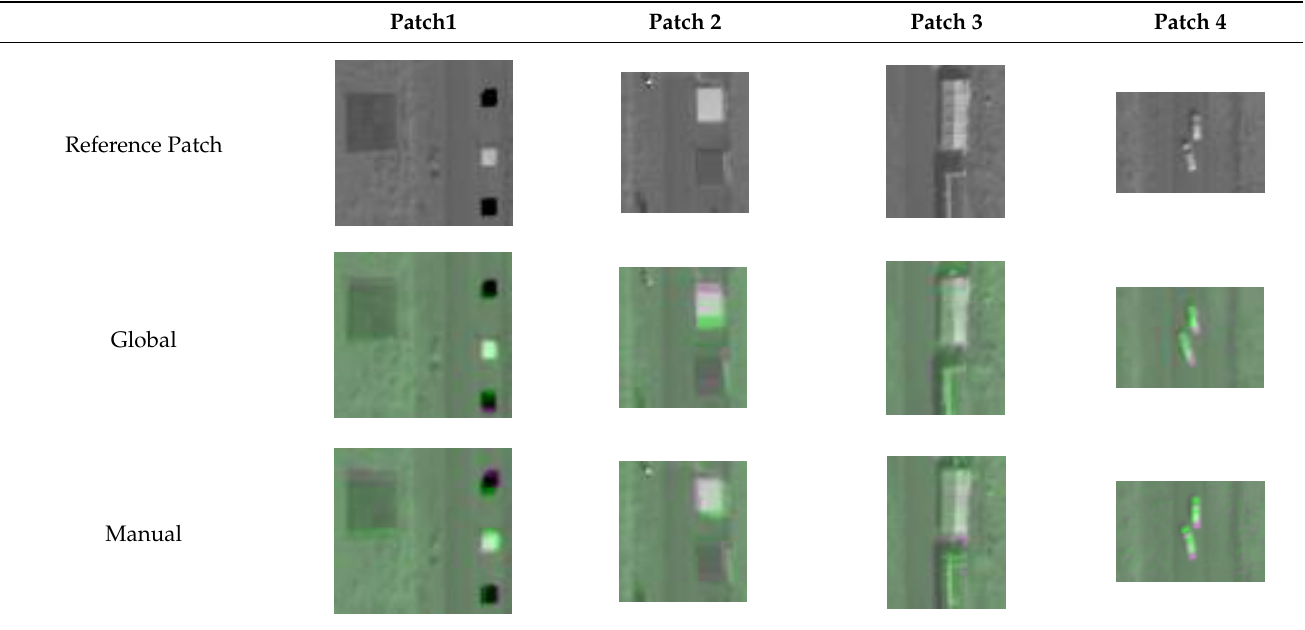
for different methods by overlapping the transformed patches with the reference patches. While the columns represent different patches, the rows indicate different methods. Gray regions in the overlapped patches indicate where the two images have similar values. Magenta and green colors correspond to the regions where the intensities are different. The regions in green or magenta, indicating the nonoverlapping parts for the patches, are quite visible for manual, global, and GPU-IMU-based registration. The same observation is also valid for the compared methods, SuperGlue [34], D2-Net [32], and LPM [33], which perform the registration with a global transformation. Accordingly, while SuperGlue and D2-Net give mismatches in the lower part of the test images, they are better in aligning the middle parts, as the global homography is estimated with respect to those regions. The reverse situation, where the lower parts are aligned regularly but the upper parts are mismatched, can also occur, as in the given example for LPM. Table 8. Examples for the overlapped reference and transformed patches for the proposed, baseline, and state-of-the-art methods. The first row indicates the original patches in the reference image.